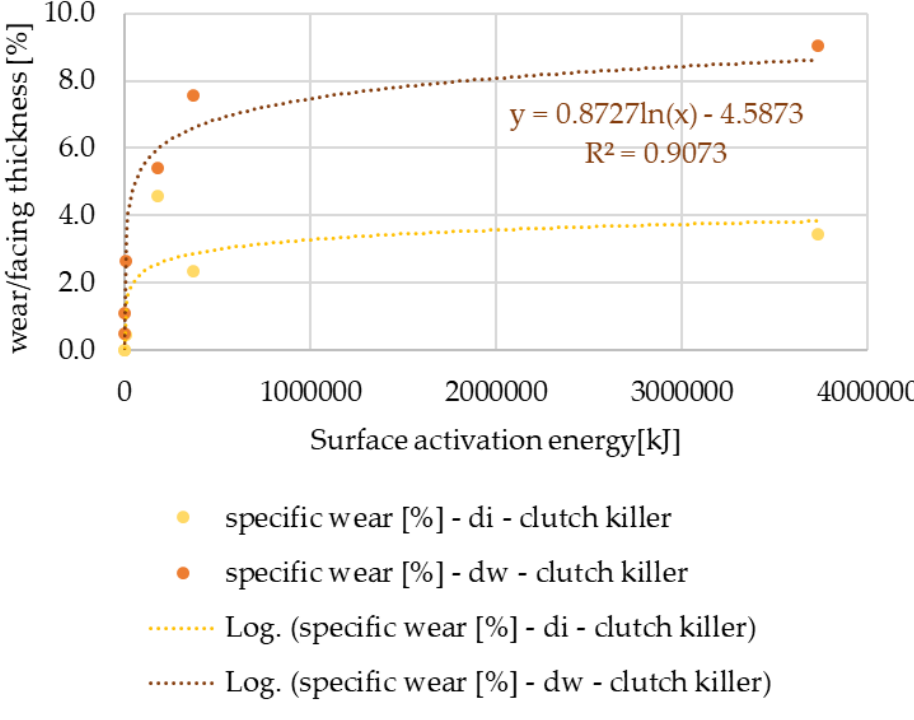
Figure 8. Wear % values versus facing thickness as a function of surface activation energy — normal use facings. It can be seen that the normal use facings show increasing wear according to a quad- ratic power function, while the values for the clutch killer-group facings show a